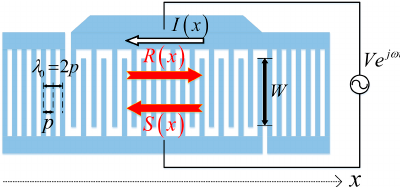
Figure 2. The schematic of the COM model for typical resonator configuration.